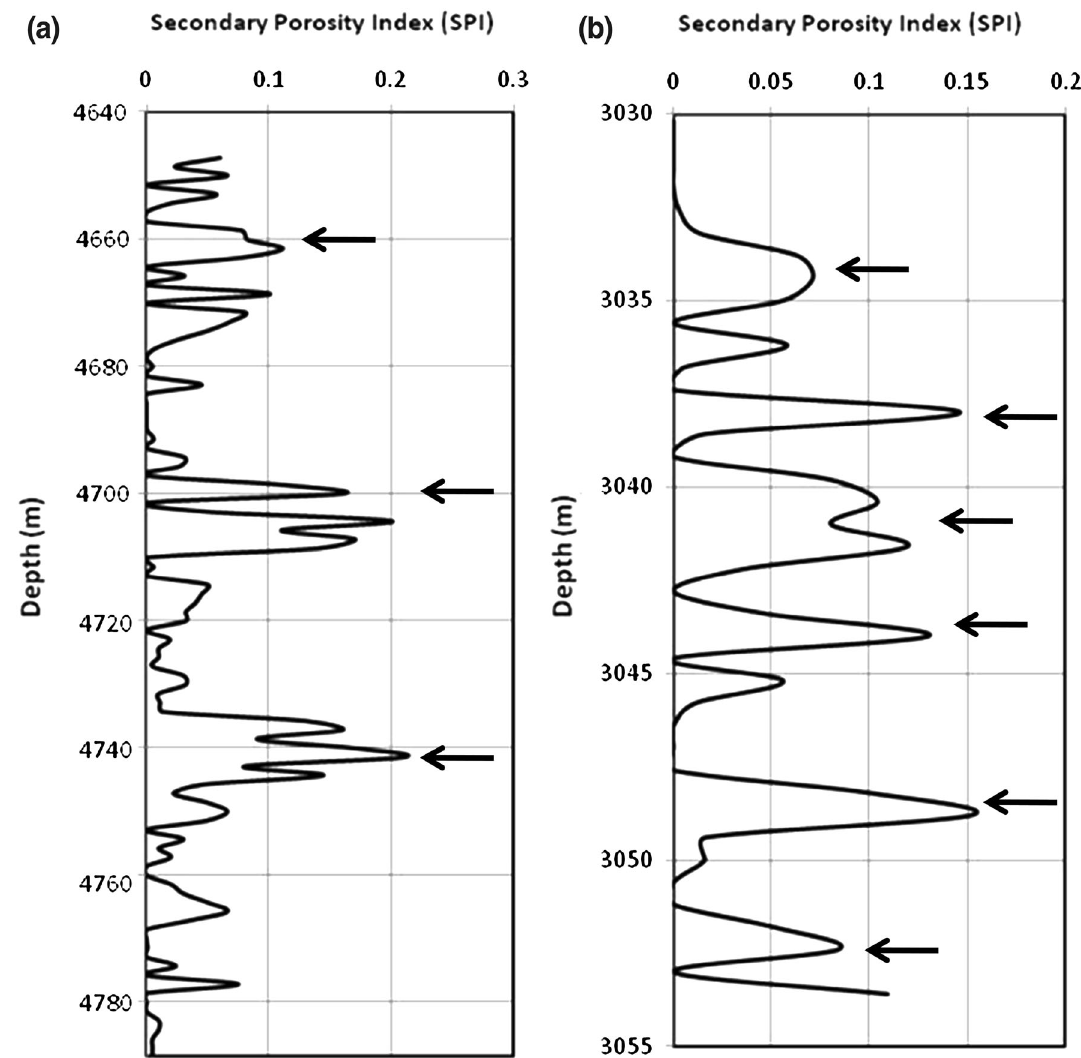
Fig. 5 Secondary porosity Index (SPI) showing probability for fractures, a in Geisum A-2 and b in Tawila N-1